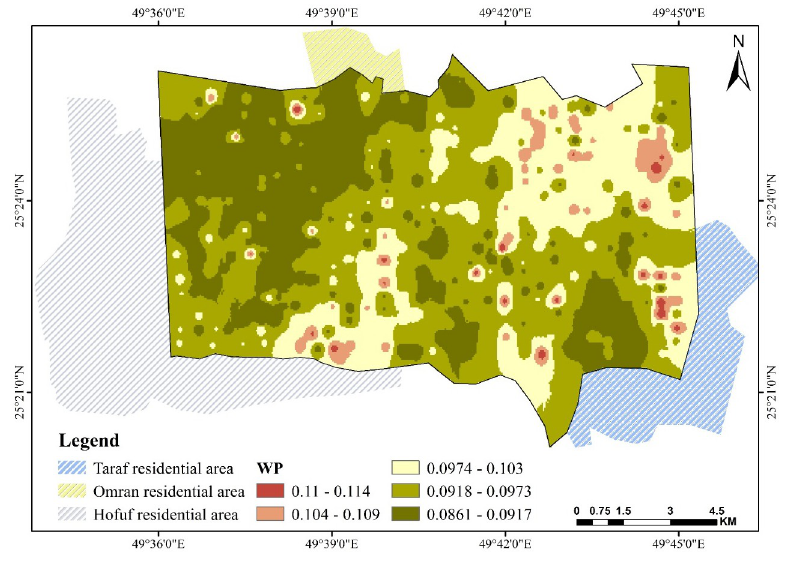
Fig 8. Spatial pattern of wilting point WP over Al-Ahsa.